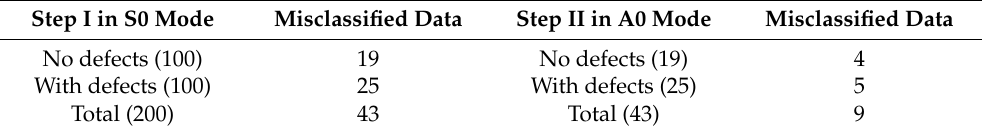
Figure 7. Classification results of ( a ) calibration data set classified by LDA in S0 mode and ( b ) data in the calibration data set misclassified by LDA in A0 mode. Table 3. Classification results for calibrating set by LDA in S0 and A0